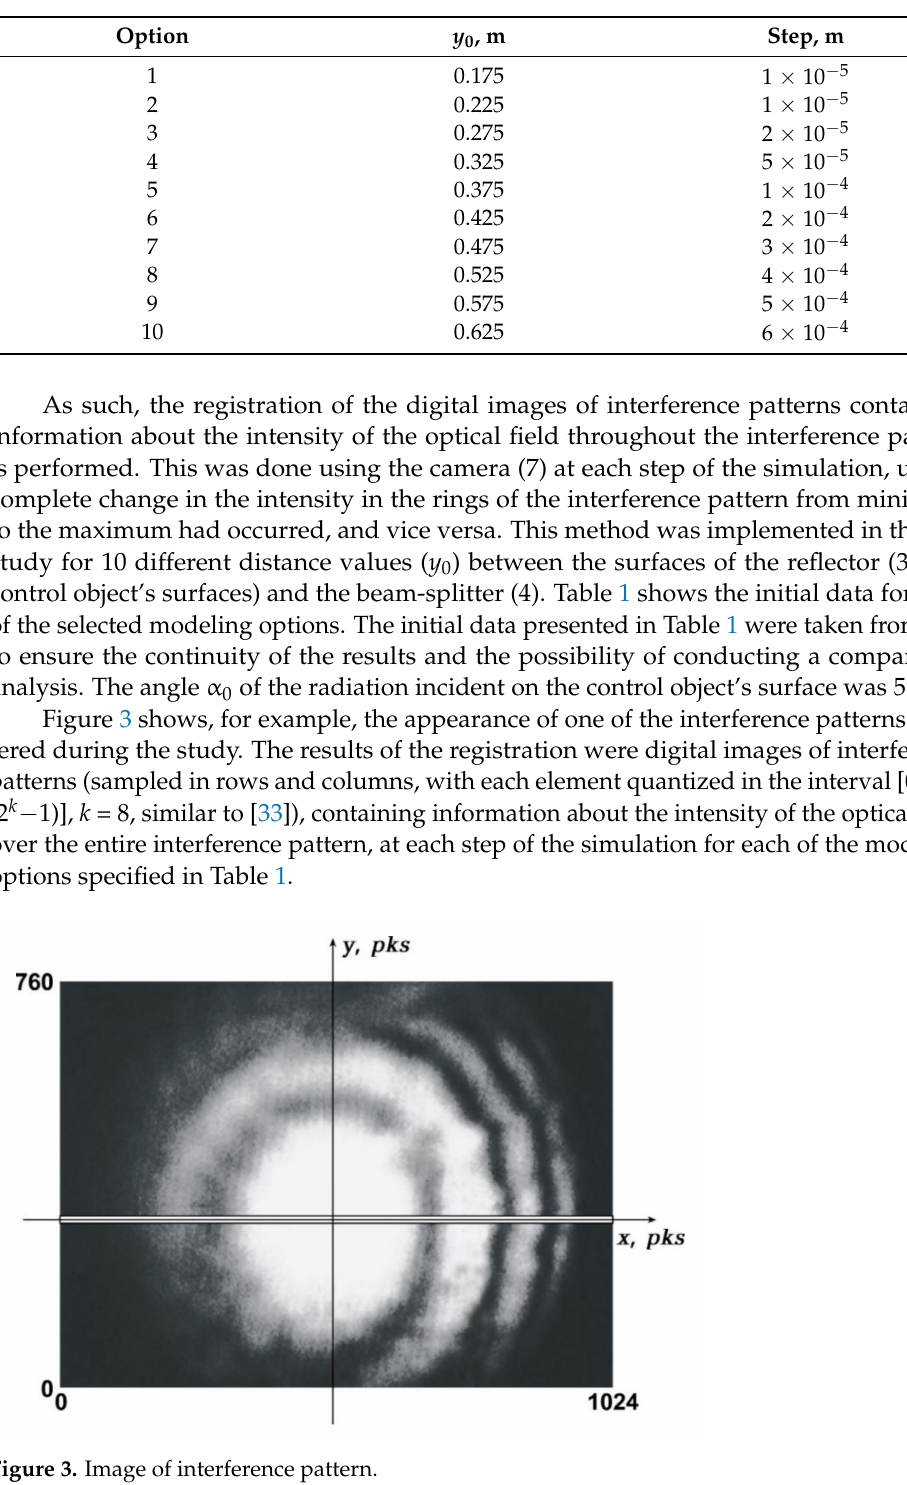
Table 1. Initial data for modeling options.